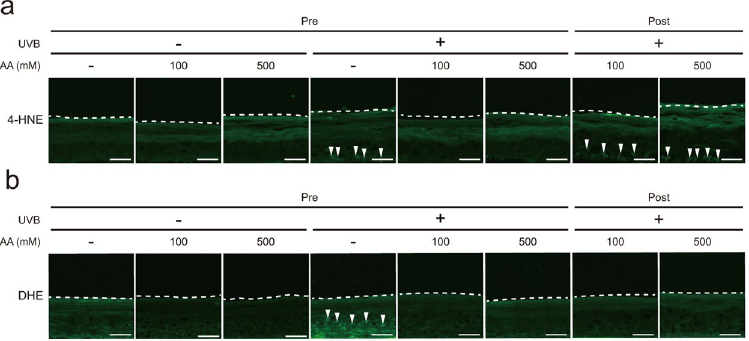
Figure 5. Effects of AA on UVB-induced oxidative damage and ROS production. AA was applied at concentrations of 100 and 500 mM to the reconstituted human epidermal surface for 3 h before or after 120 mJ/ cm 2 UVB irradiation. After UVB irradiation, the epidermis was cultured for 24 h. ( a ) Immunofluorescence staining for 4-HNE as a maker of lipid peroxidation. White arrowheads indicate 4-HNE-positive cells. ( b ) ROS levels in the epidermis were detected by DHE staining. White arrowheads indicate ROS-positive cells. The dotted line represents the bottom of the cornified layer. Bar = 50 µ m.